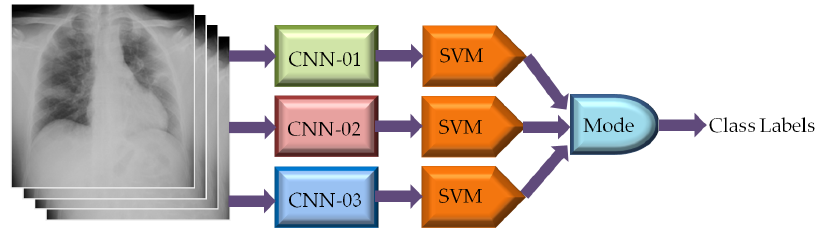
Figure 9. The assigning of class label to a new test sample using KNN classifier.